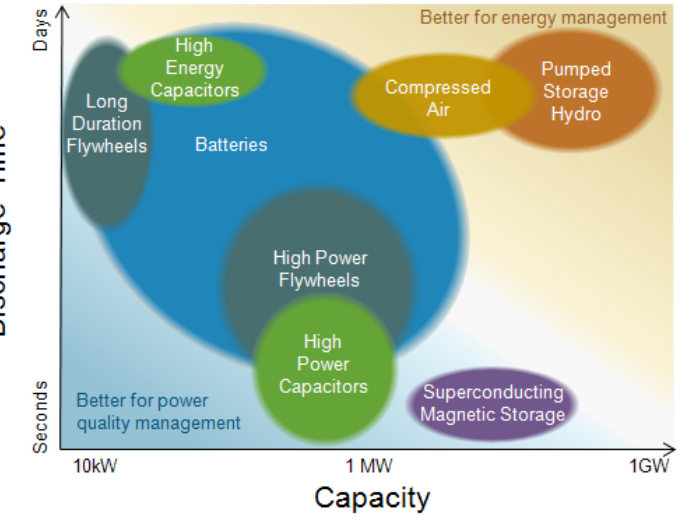
Figure 5. Electricity storage technologies